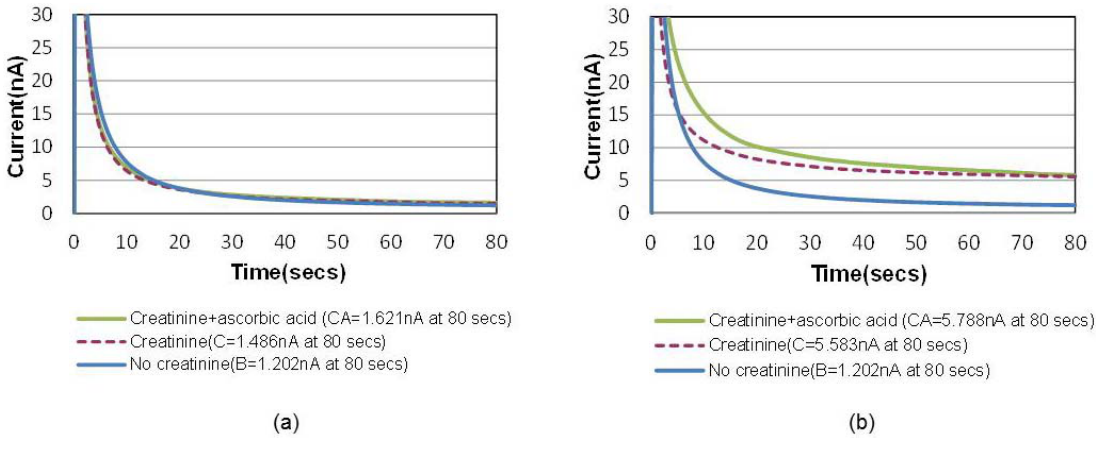
Figure 6. Chronoamperometric responses for a creatinine concentration of 15 mg/dL with and without 1 mg/dL ascorbic acid (t = 0 s corresponds to t = 150 s in Figure 3). ( a ) Responses in a creatinine solution saturated with air; ( b ) Responses in a creatinine solution saturated with an oxygen bubble at optimized final distance of 1 mm and current density 5.5 mA/cm 2 . The ratio of interference signal ( i.e. , pure creatinine signal/ascorbic noise = [C–B]/[(CA)–C]) is suppressed in ( b